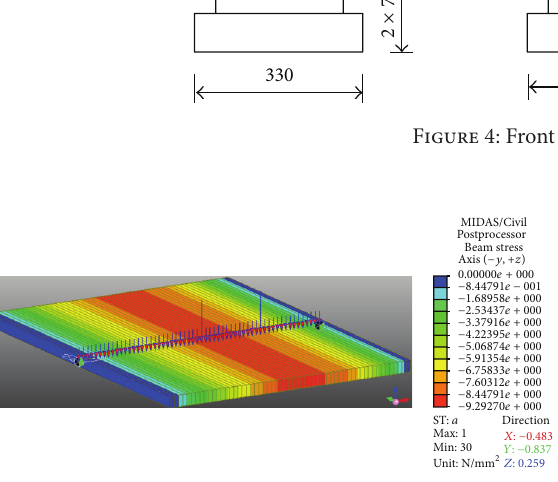
Figure 7: Calculation result of